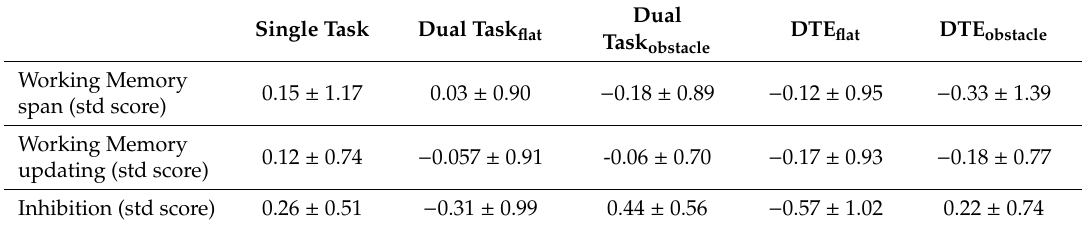
Table 5. Means and standard deviations ( n = 135) of cognitive variables in all testing conditions: low versus high cognitive demands (working memory span obtained from backward counting (BC) versus working memory updating and inhibition obtained from random number generation (RNG)) in single task (ST) or dual task (DT) with low versus high environmental constraints (flat versuss obstacle). Dual Single Task Dual Task flat DTE flat DTE obstacle Task obstacle Working Memory 0.15 ± 1.17 0.03 ± 0.90 − 0.33 ± span (std score)